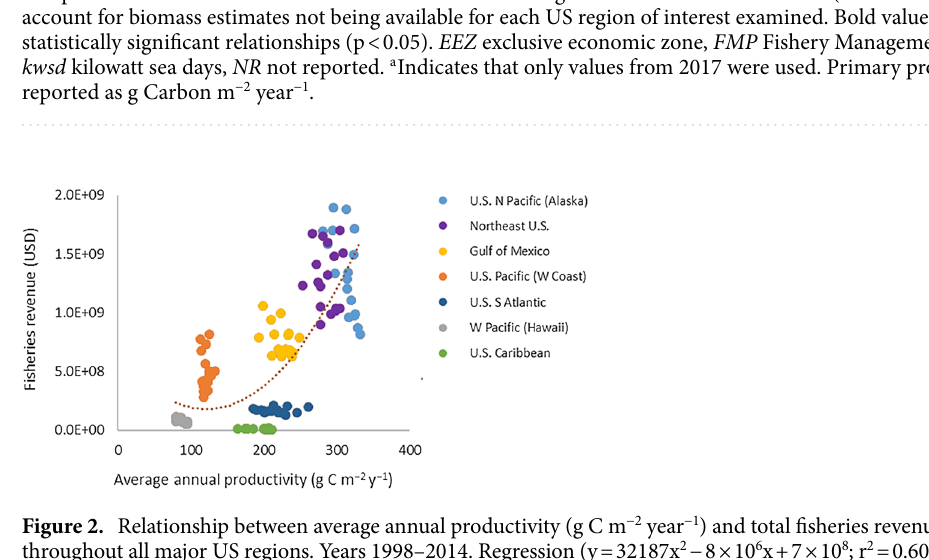
(Fig. 1c). Total landings are related to fisheries revenue (i.e., fisheries performance; Fig. 1d), which is ultimately set by total biomass (Fig. 1e) and results in the main relationship that primary productivity is strongly related to total fisheries revenue (Fig. 2). Extending these associations to recognize the positive relationship between fisheries landings and LMR-based employment (Fig. 3a) implies that primary productivity can influence regional ocean employment (Fig. 3b), and percentages thereof for an entire regional ocean-based economy (Fig. 3c,d). Annual fisheries revenue and LMR-based employment are highly dependent on the quantity (shown for US regions, Figs. 1d, 3a,c) and quality of landings 2–4,25 . Greatest US fisheries revenues over the past two decades have generally been observed in higher-latitude, productive systems, with values highest for the US North Pacific (i.e., Alaska), Northeast US, Gulf of Mexico, and US Pacific (i.e., West Coast) regions. Fisheries landings in the